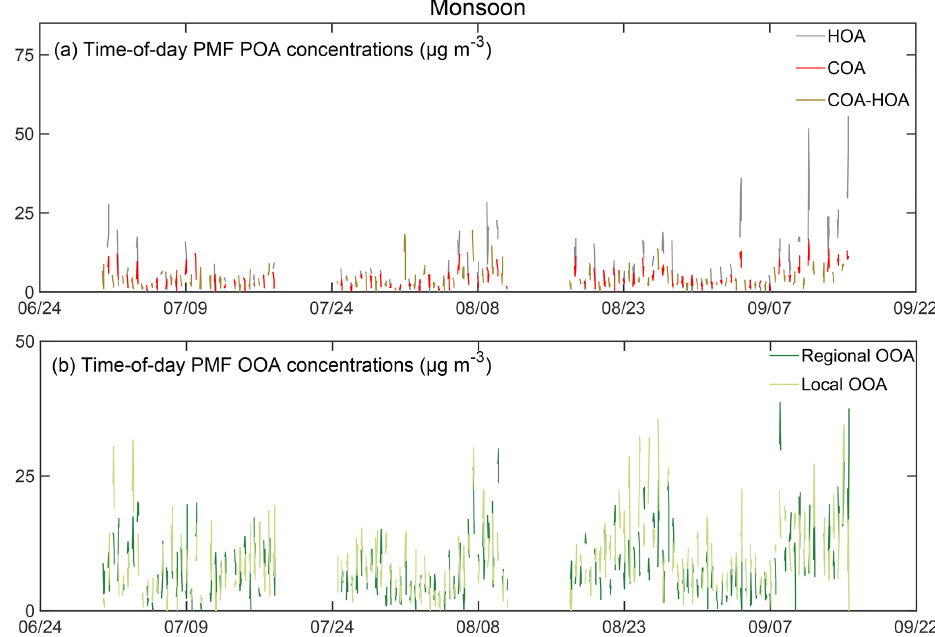
Figure 2. Hourly averaged seasonally representative concentration time series of time-of-day PMF (a) primary and (b) secondary factors for the 2017 monsoon season (in µgm − 3 ) . POA PMF factors show stronger variability than OOA PMF factors. (Chopped lines are due to analysis conducted on two 4h periods each